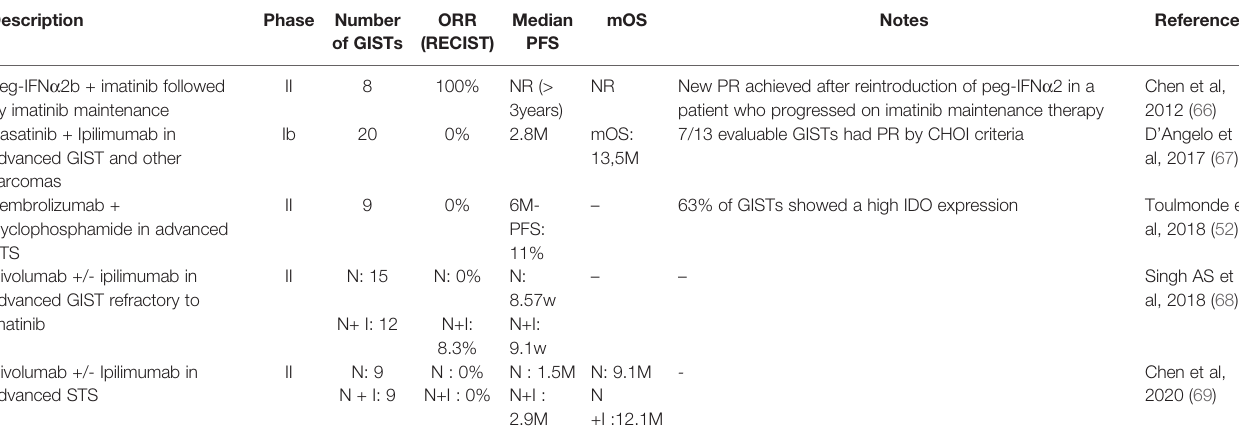
TABLE 3 | Results of clinical trials evaluating immunotherapeutic approaches in GIST.